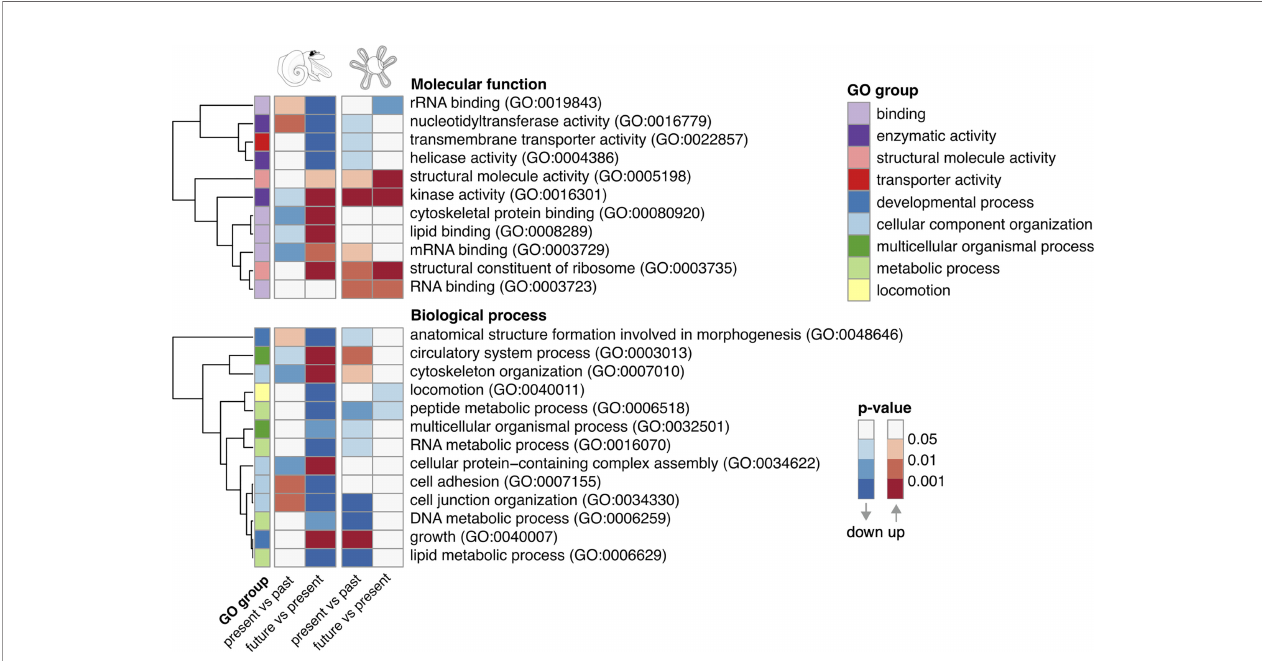
FIGURE 3 | Enriched gene ontology terms among upregulated (red) or downregulated (blue) genes in the pairwise comparisons present versus past and future versus present, for juveniles (right) and adults (left) of the species Atlanta ariejansseni . In juveniles fi ve GO terms are regulated in the same direction (same color: red or blue) for both comparisons. By contrast, 12 GO terms are regulated in opposing directions in adults. The GO terms are grouped by molecular function and biological process. The color sequences indicate that the enriched GO terms passed an adjusted p-value threshold of 0.05 or